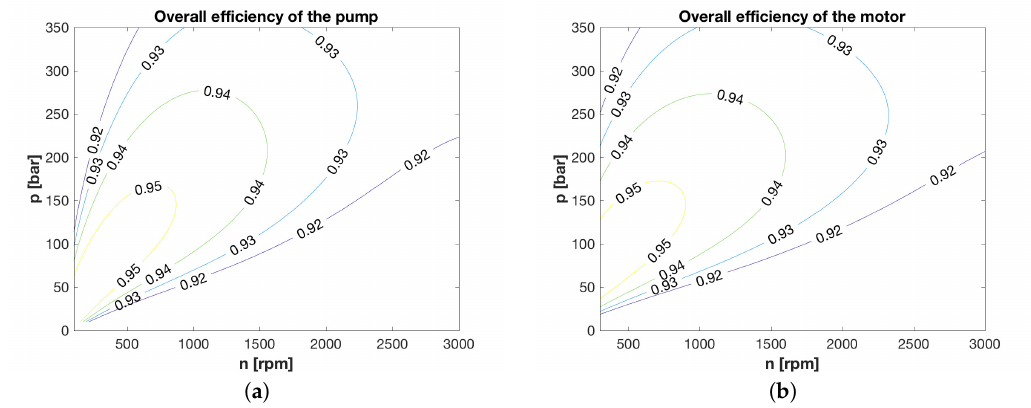
Figure 5. Contour plot of the total efficiency of the floating cup ( a ) pump and ( b ) motor at full displacement. The contour plots were obtained through our physical model of the hydraulic machine obtained following [39] and the fitting data of [35], also in terms of partial